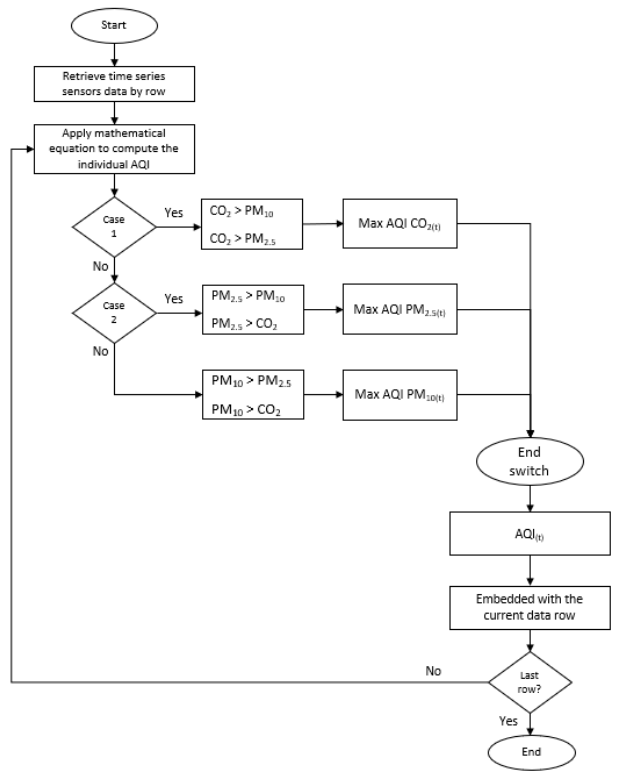
Figure 7. The time series data labelling of the